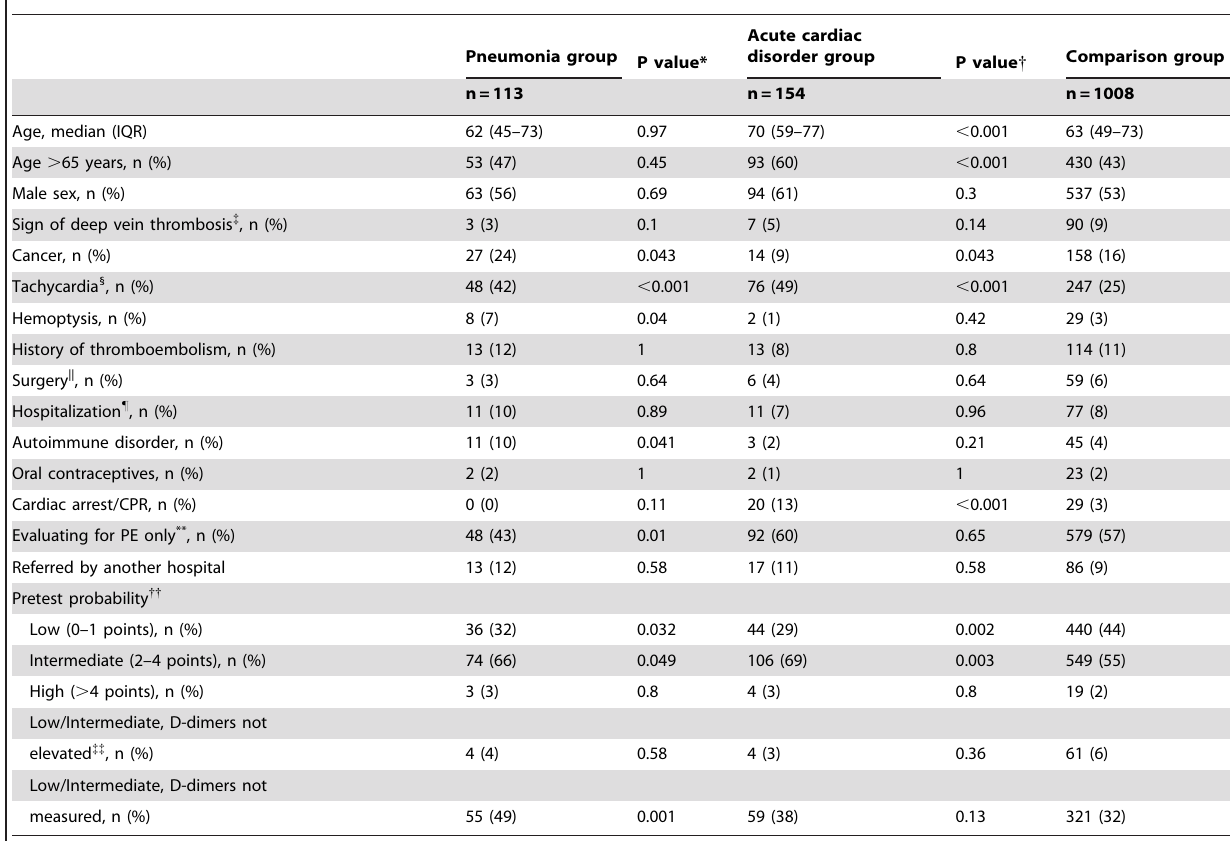
Table 1. Characteristics of